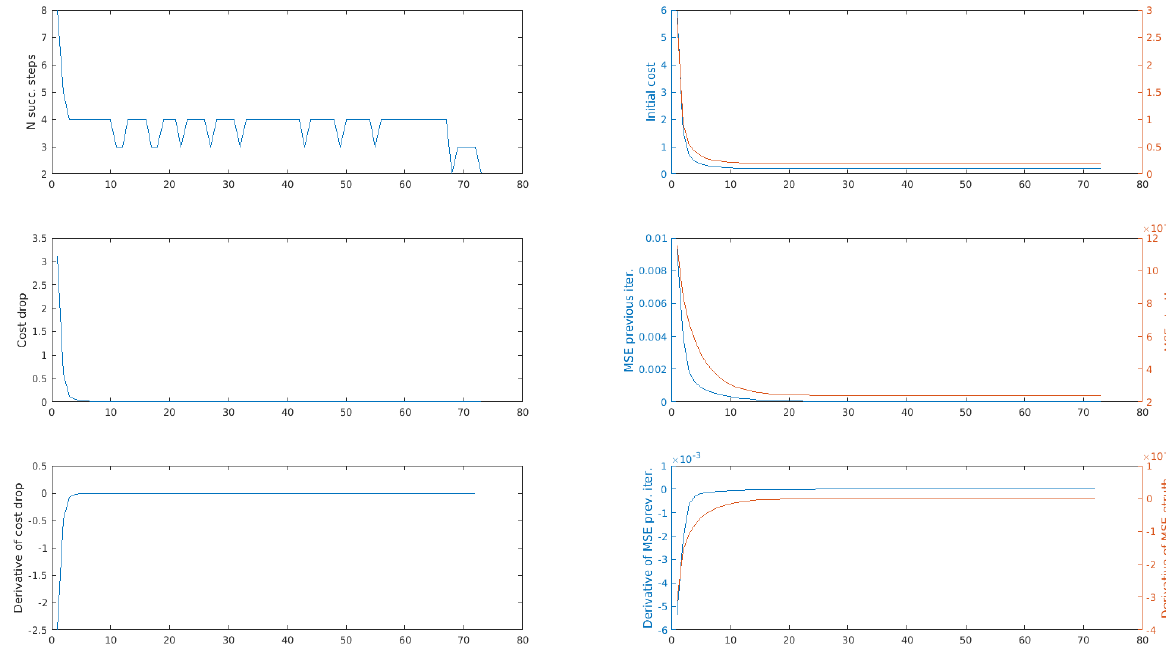
Figure 2. Plots of various termination criteria and their derivative for two point clouds from the Stanford Bunny